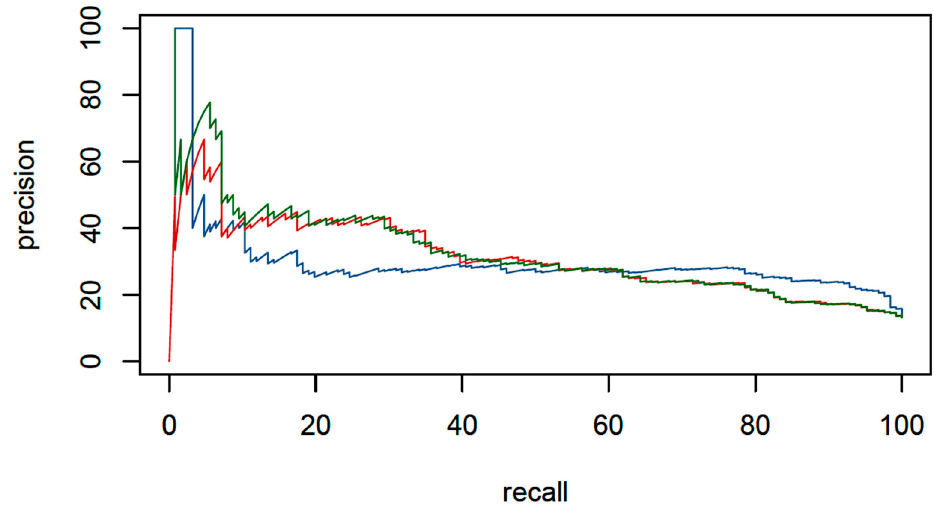
Figure 4. Precision–recall curves. The blue curve represents the analysis using the XGBoost package. For the red curve, glm was used, and for the green curve BMA was used. precision = PPV = (true positive)/(true positive + false positive). recall = sensitivity = (true positive)/(true positive + false negative).